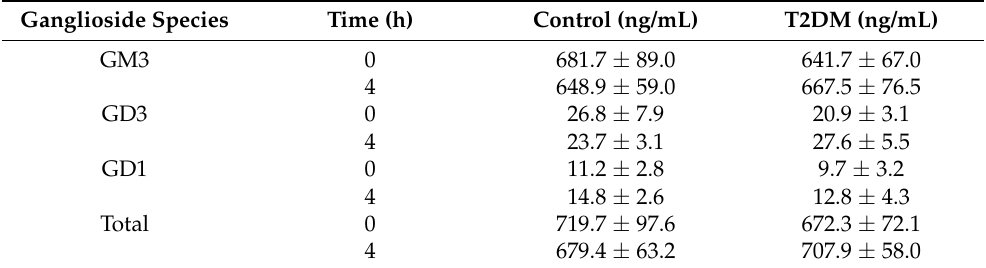
Table 3. Concentration (ng/mL) of GM3, GD3, GD1 and total ganglioside at fasting and in postpran- dial plasma samples.